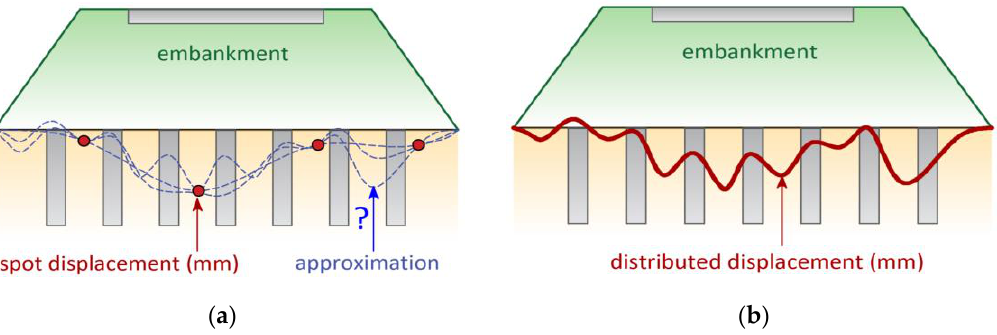
Figure 1. Idea of embankment settlement measurements using: ( a ) spot technique; ( b ) distributed technique.